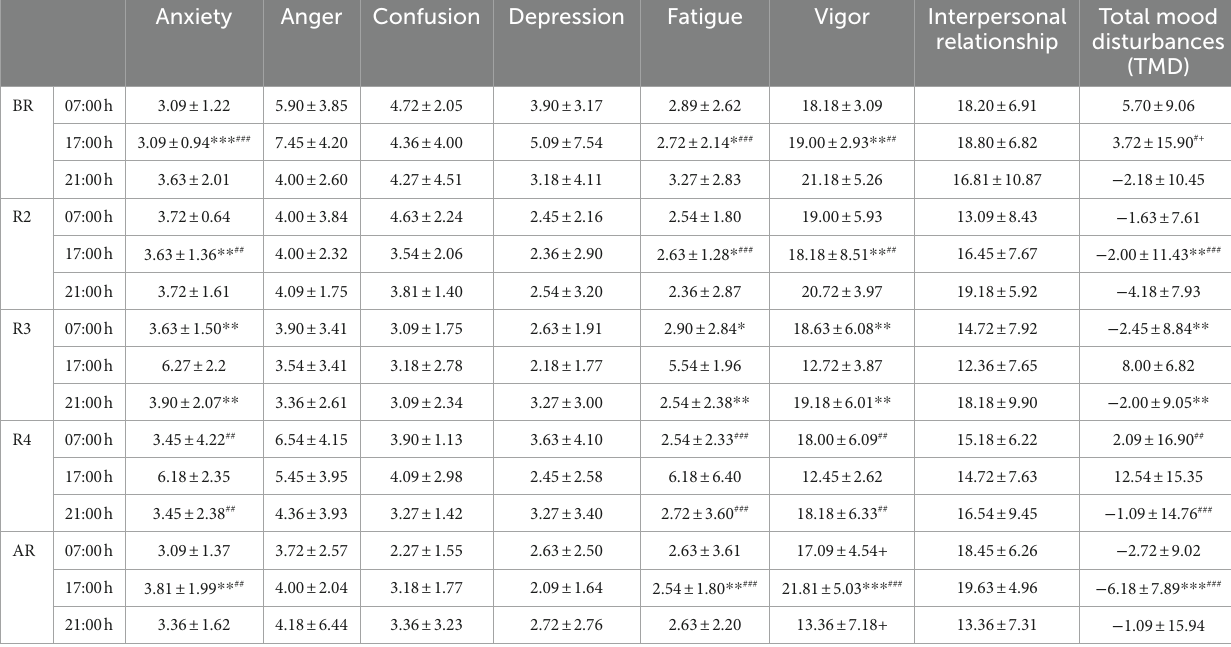
TABLE 3 Values (mean ± SD) of anxiety, anger, confusion, depression, fatigue, vigor, interpersonal relationship and total mood disturbances (TMD) scores registered by the Profile of Mood State (POMS) questionnaire during the three times of the day (07:00, 17:00, and 21:00 h) 1 week before Ramadan (BR), during the 2nd week of Ramadan (R2), the 3rd week (R3), the 4th week of Ramadan (R4) and 2 weeks after Ramadan (AR; n = 11).